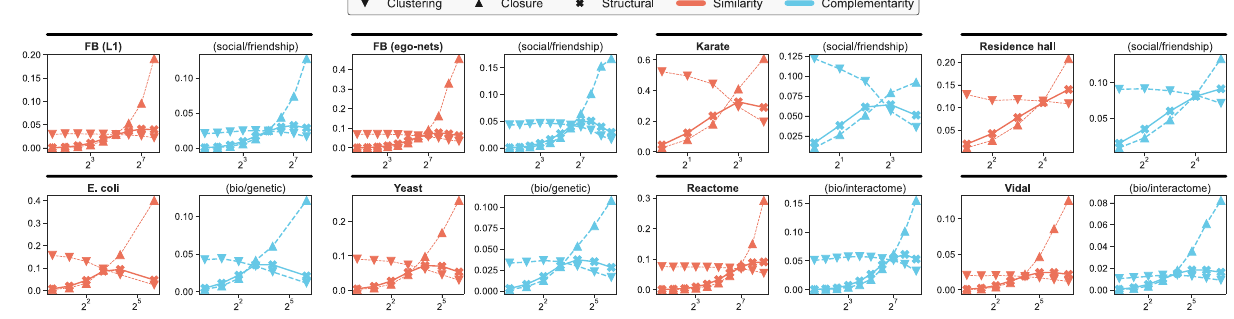
Figure 5. Correlations of clustering, closure and structural coefficients with node degrees in configuration model ensembles based on degree sequences from 8 real-world social and biological networks. See the SI (Fig. S1) for full results based on 28 networks and the description of the datasets. Null distributions of the coefficients were approximated based on 100 samples from Undirected Binary Configuration Model